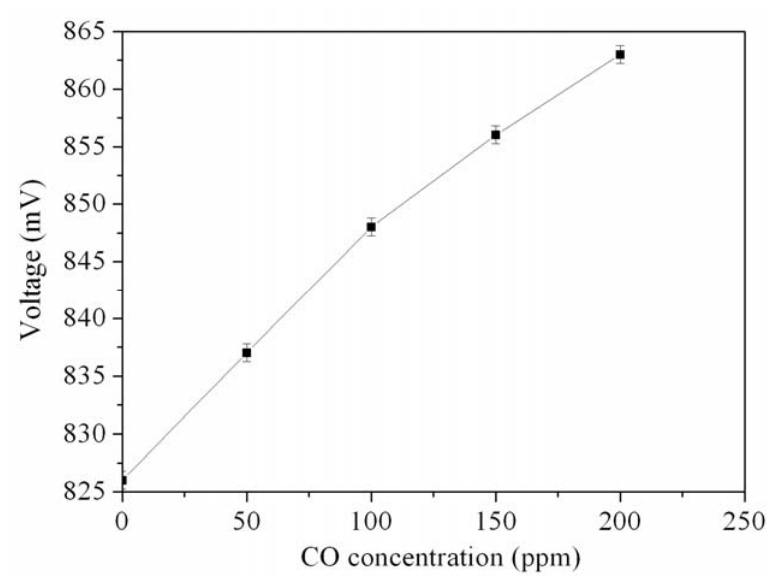
Figure 12. Measured results of the output voltage for the CO